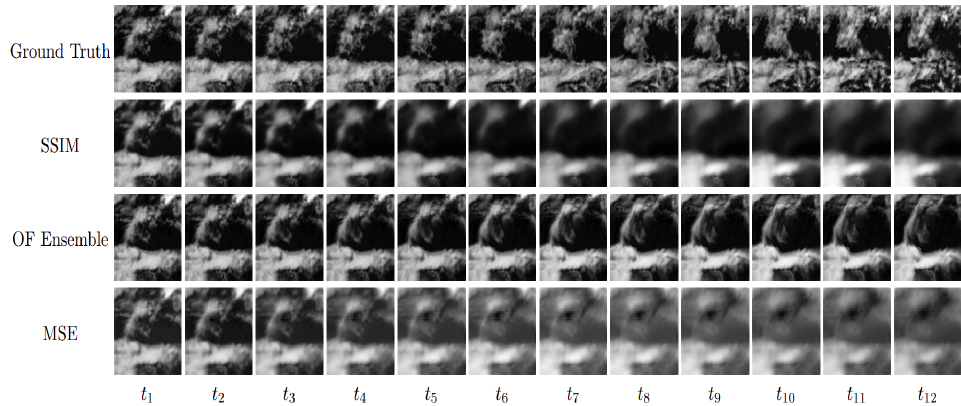
Figure 8. Example 3 h nowcasts over the Netherlands on 9 June